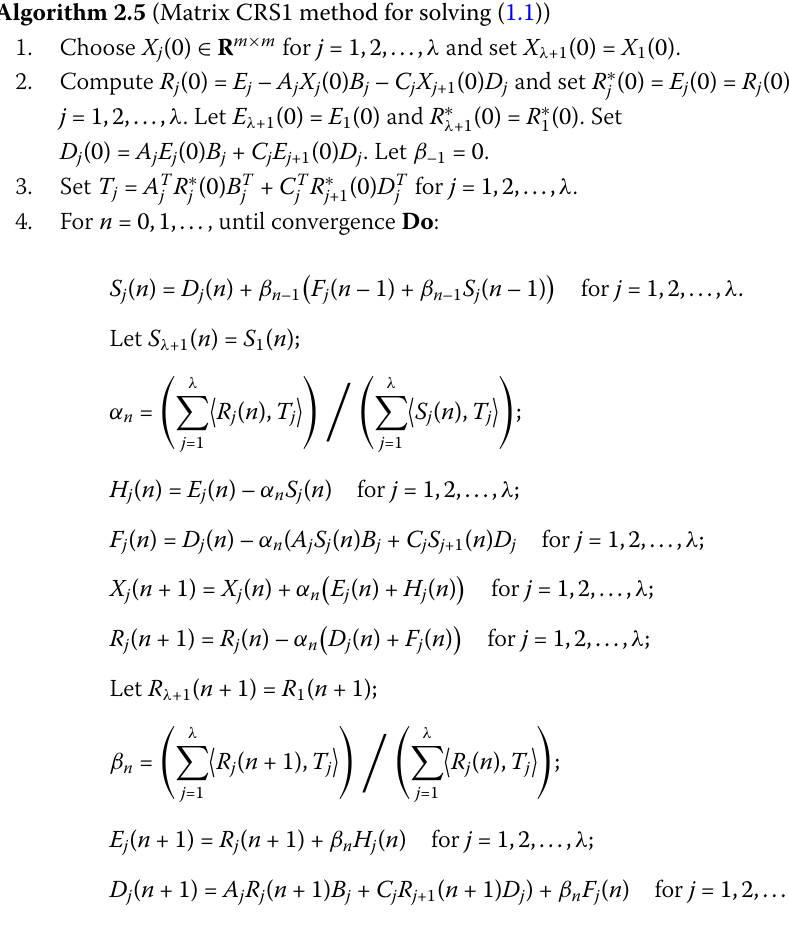
Algorithm 2.5 (Matrix CRS1 method for solving